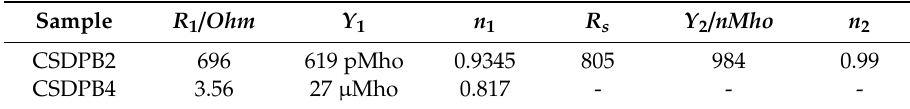
Table 2. The parameters of the circuit elements of the selected blend electrolyte membranes at ambient temperature.